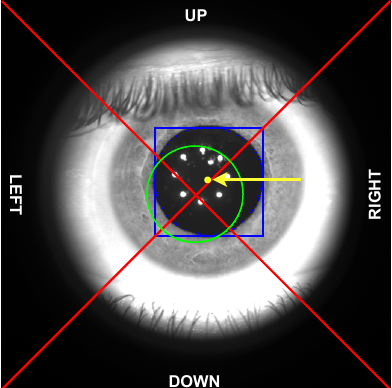
Figure 3. Visual aids used for the data annotation phase. The two diagonals in red define the four cardinal regions, named: up, right, down, and left . The green circle determines the central region for “correct” images. The ES algorithm (described in Section 4.1) finds and highlights the pupil bounding box (blue square) and the pupil center (yellow dot, highlighted by yellow arrow) whenever possible to support the human operator in the labeling